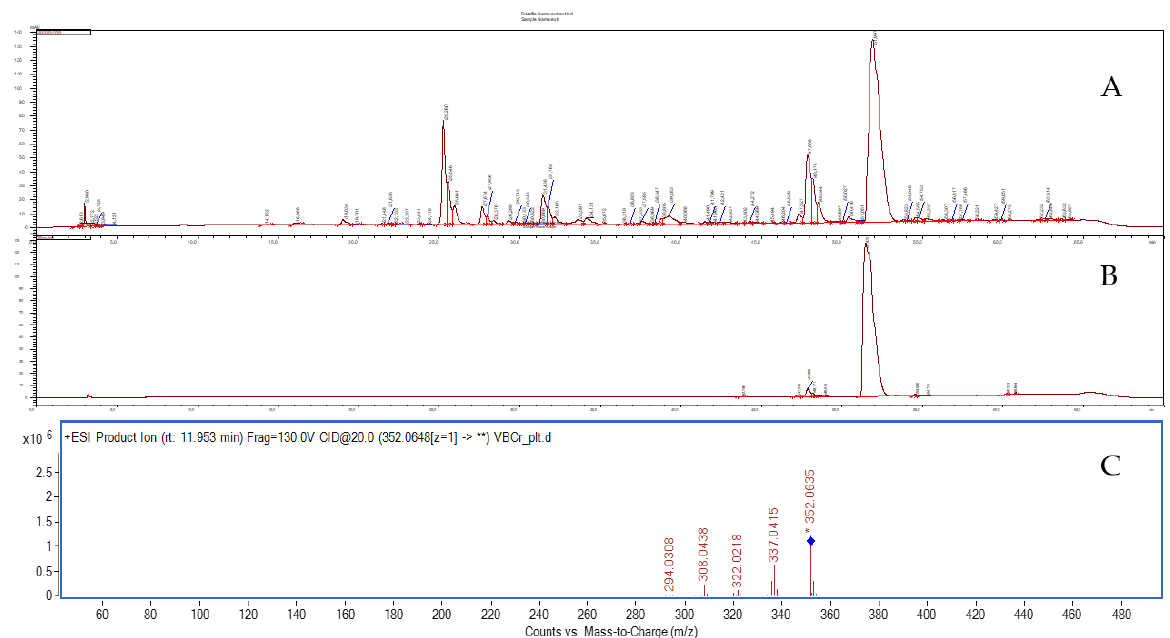
Figure 2. The HPLC-DAD chromatogram of the total extract from Berberis cretica root recorded at 280 nm ( A ); the HPLC- DAD chromatogram of purified palmatine( B ); the MS/MS spectrum of palmatine recorded in the fragmentation energy of 130 V and collision energy of 20V ( C ).